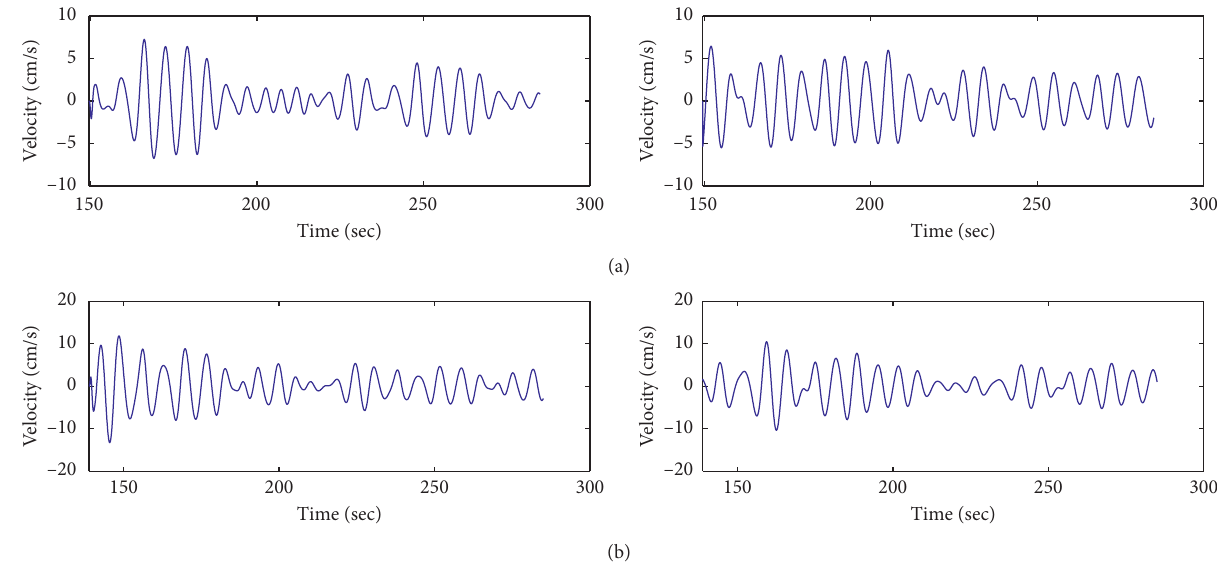
Figure 7: Simulated long-period surface waves in the form of velocity time series. (a) CHB002EW and (b)